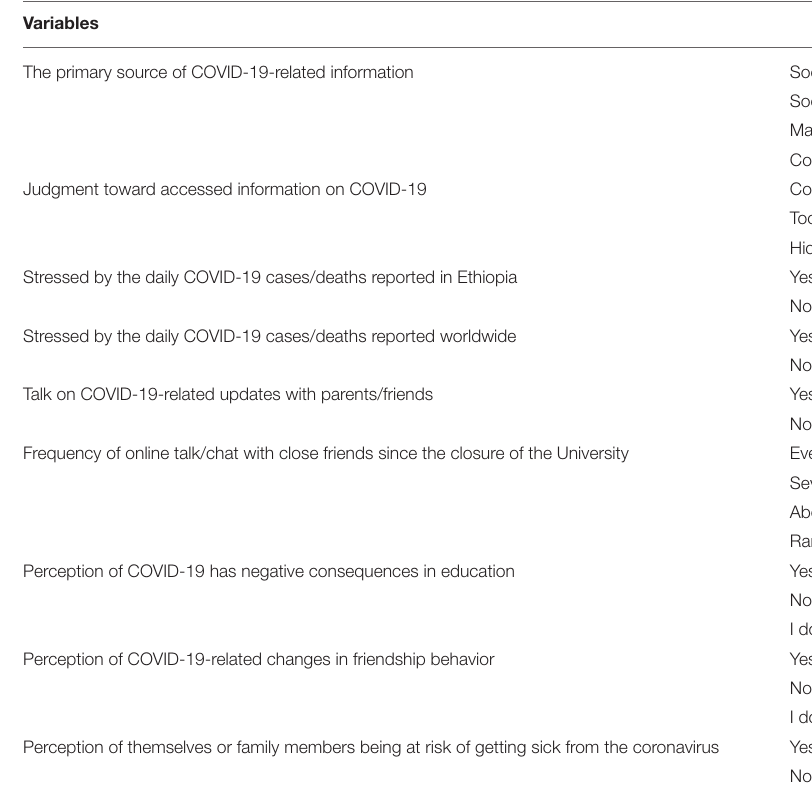
TABLE 2 | COVID-19-related experience among the